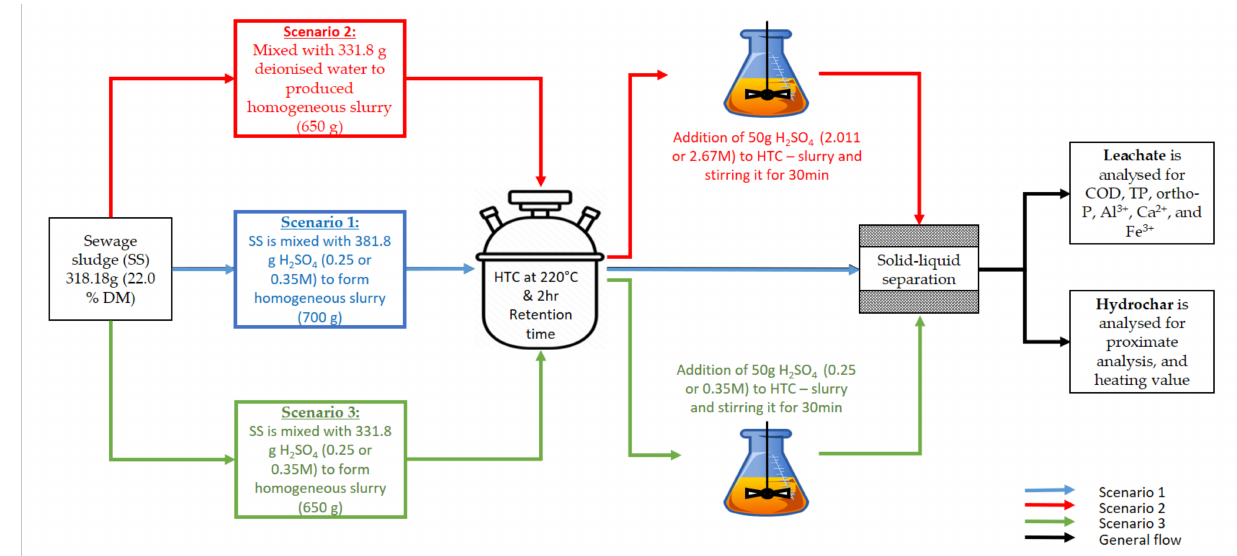
Figure 1. Overview of the experimental methodology.